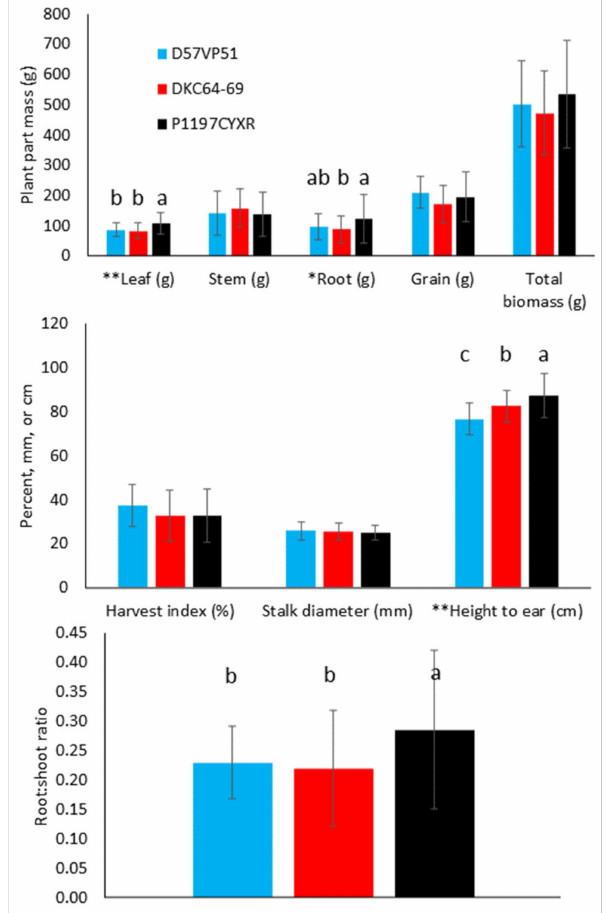
Figure 1. Biomass and plant measurements for each hybrid averaged across six phosphorus concen- tration treatments and four replications. “Stem” includes stem, cob, and tassel, and “Leaf” includes leaves and husk. * and ** indicate a significant hybrid effect at p -levels ≤ 0.05 and ≤ 0.01, respectively. Error bars indicate standard deviation. All mass presented on dry weight basis except for grain (15.5% moisture). Bars topped by the same letter did not differ as assessed by Least Significant Difference ( p ≤